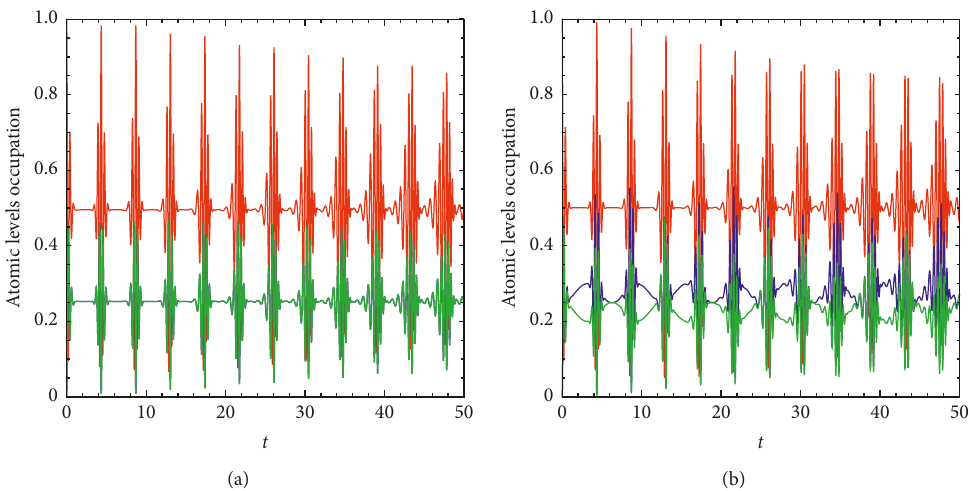
Figure 4: The evolution of the atomic levels occupation as a function of the scaled time t ,